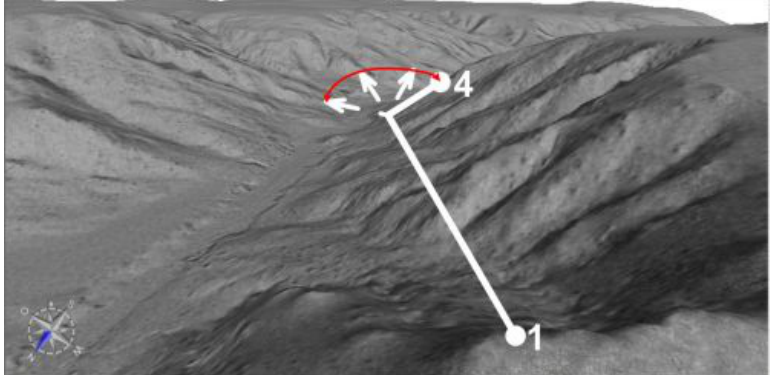
Figure 11. A constructed ray (1-4, full white line) traversing a slope is classified as a cross-section due to the large value of the central angle (red) of circular sectors used for detecting endpoints of cross-sections.